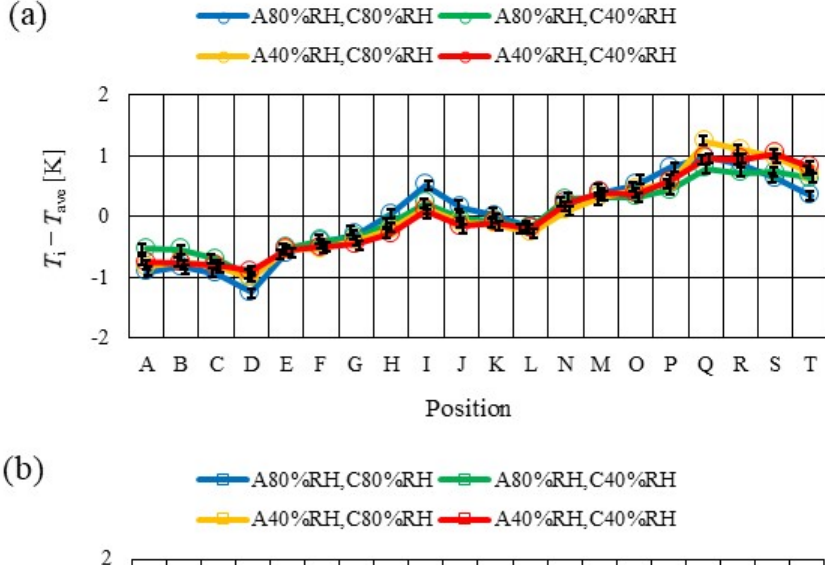
Figure 10. Comparison of the in-plane temperature distribution at the anode side among different RHs in the case of the separator thickness of 2.0 mm: ( a ) T init = 353 K; ( b ) T init = 363 K; ( c ) T init = 373 K.